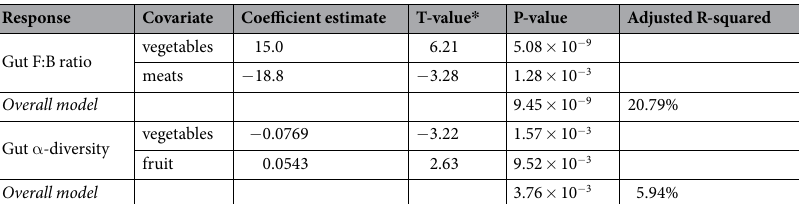
Response Covariate Coefficient estimate T-value * P-value Adjusted R-squared vegetables Gut F:B ratio